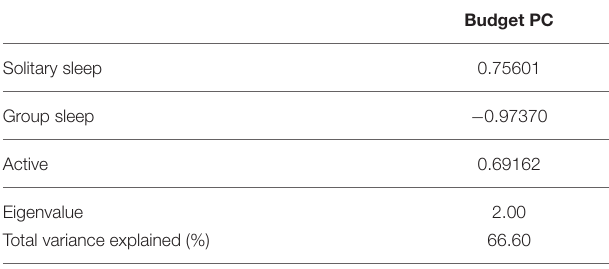
TABLE 2 | Loading values from Principal Component Analysis of time budget